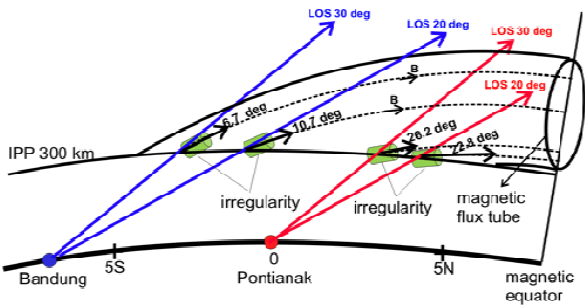
Fig. 9. Angles between the lines of sight (LOS) and magnetic field line at an altitude 300km as observed from (a) Bandung and (b) Pontianak.